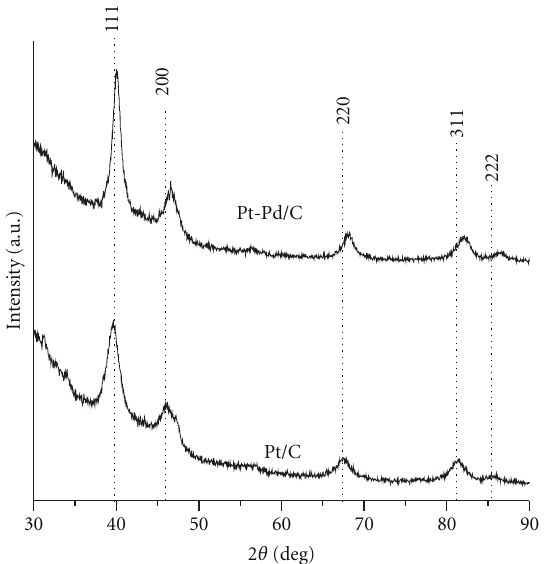
Figure 2: X-ray di ff raction (XRD) pattern of Pt/C and Pt-Pd/C electrocatalysts.